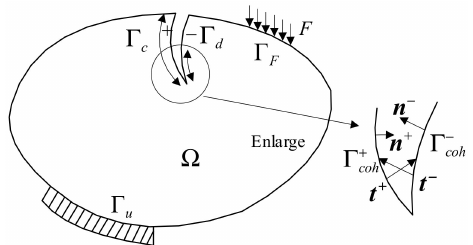
Figure 3. Schematic diagram of the cohesive